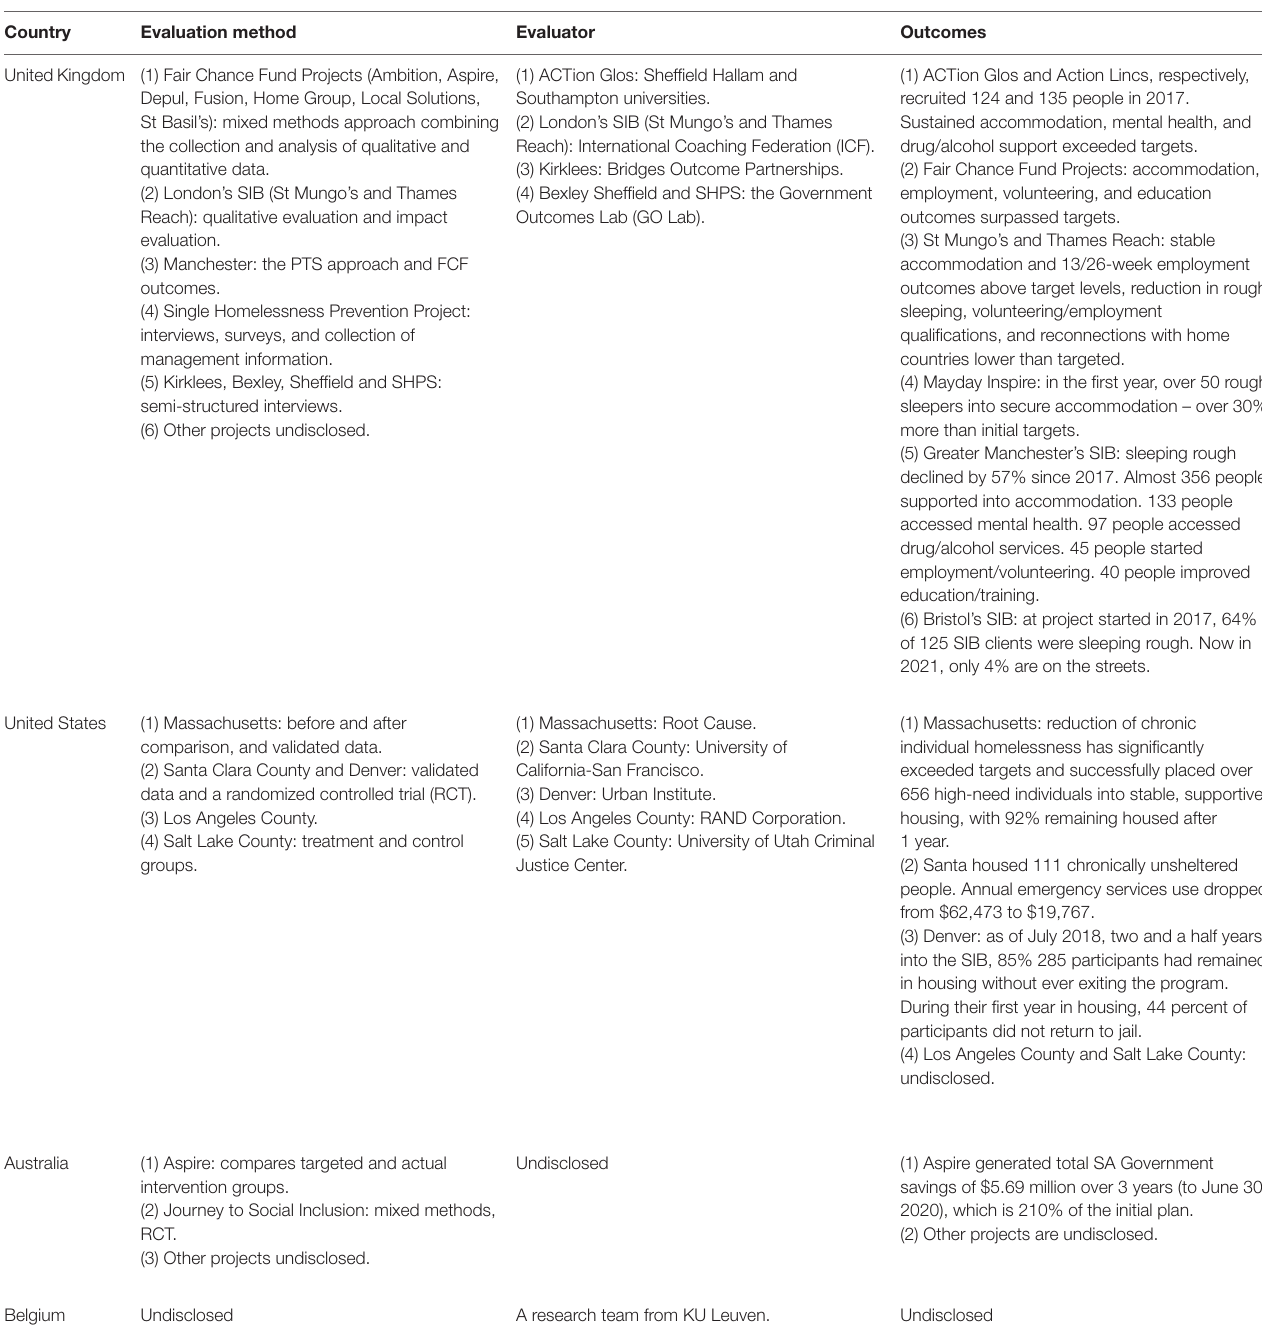
TABLE 5 | Evaluation methods and outcomes of all SIBs for homelessness.